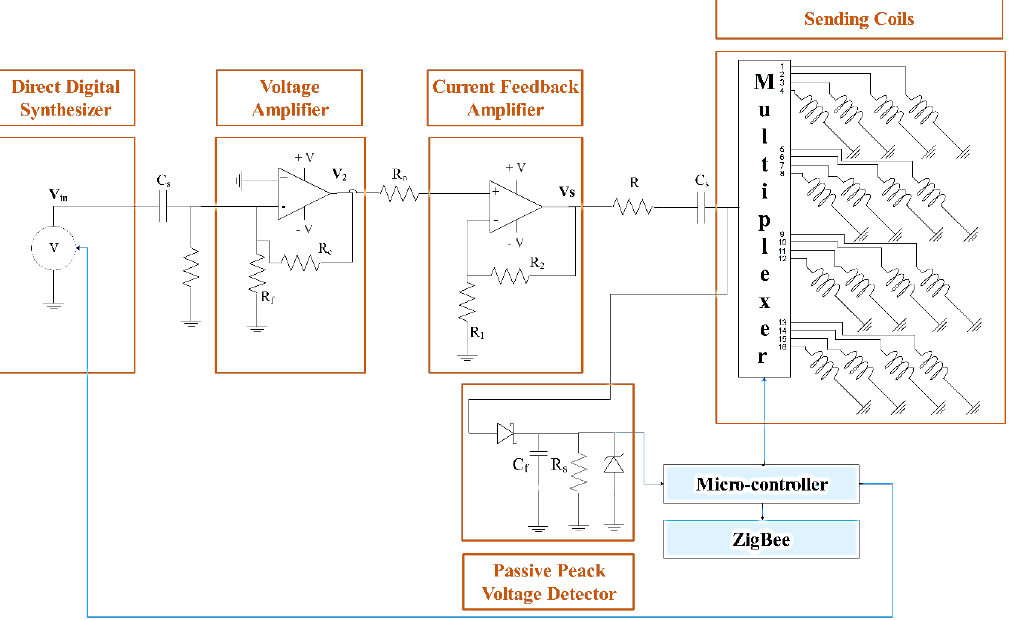
Figure 2. Proposed primary side multiplexed supply for a MISO-WPT system with 16 coils.